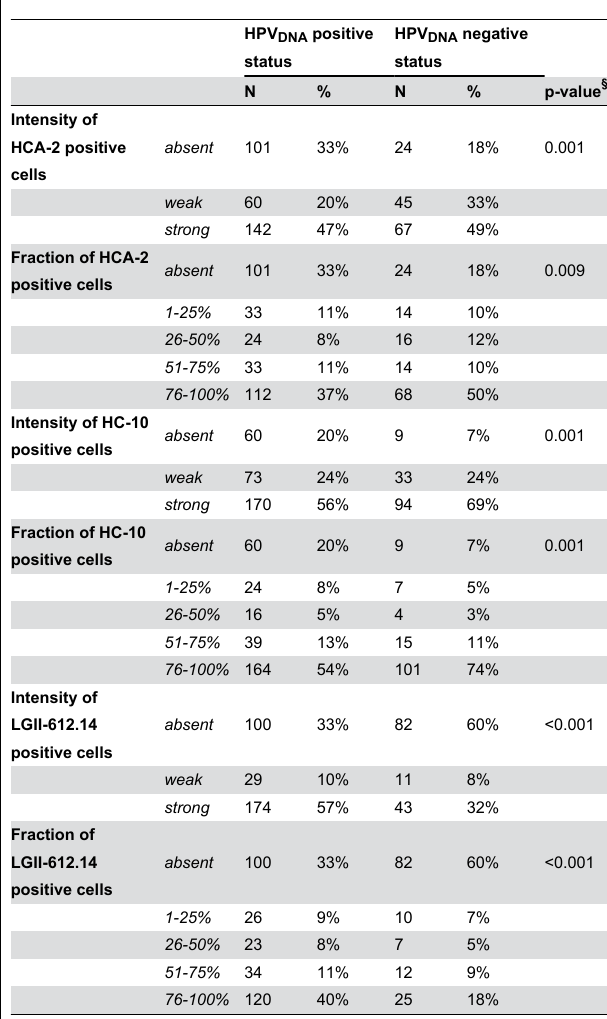
Table 2. HLA class I and II exptression in HPV DNA positive and HPV DNA negative oropharyngeal